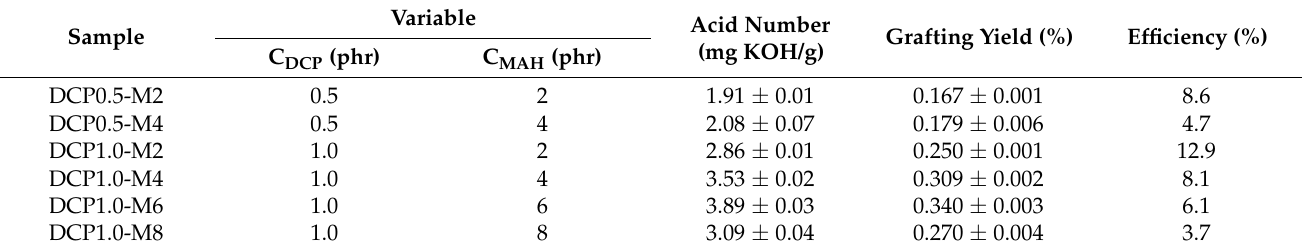
Table 1. Grafting yield of PLA-g-MAH